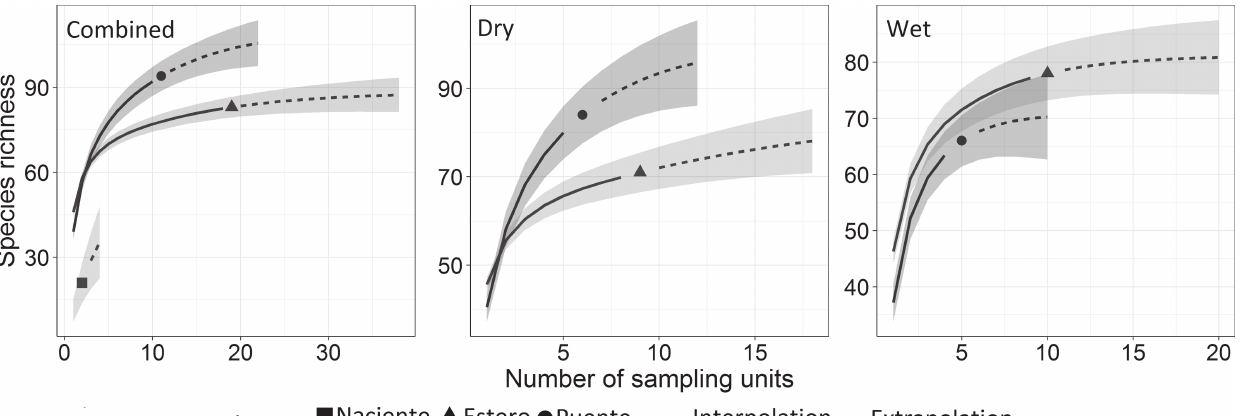
Fig. 2. Rarefaction curves with extrapolations for fish assemblages at two survey sites (circle- Puente, triangle- Estero) during dry and wet seasons and all periods combined (square- Naciente) (Hill’s number order q= 0).